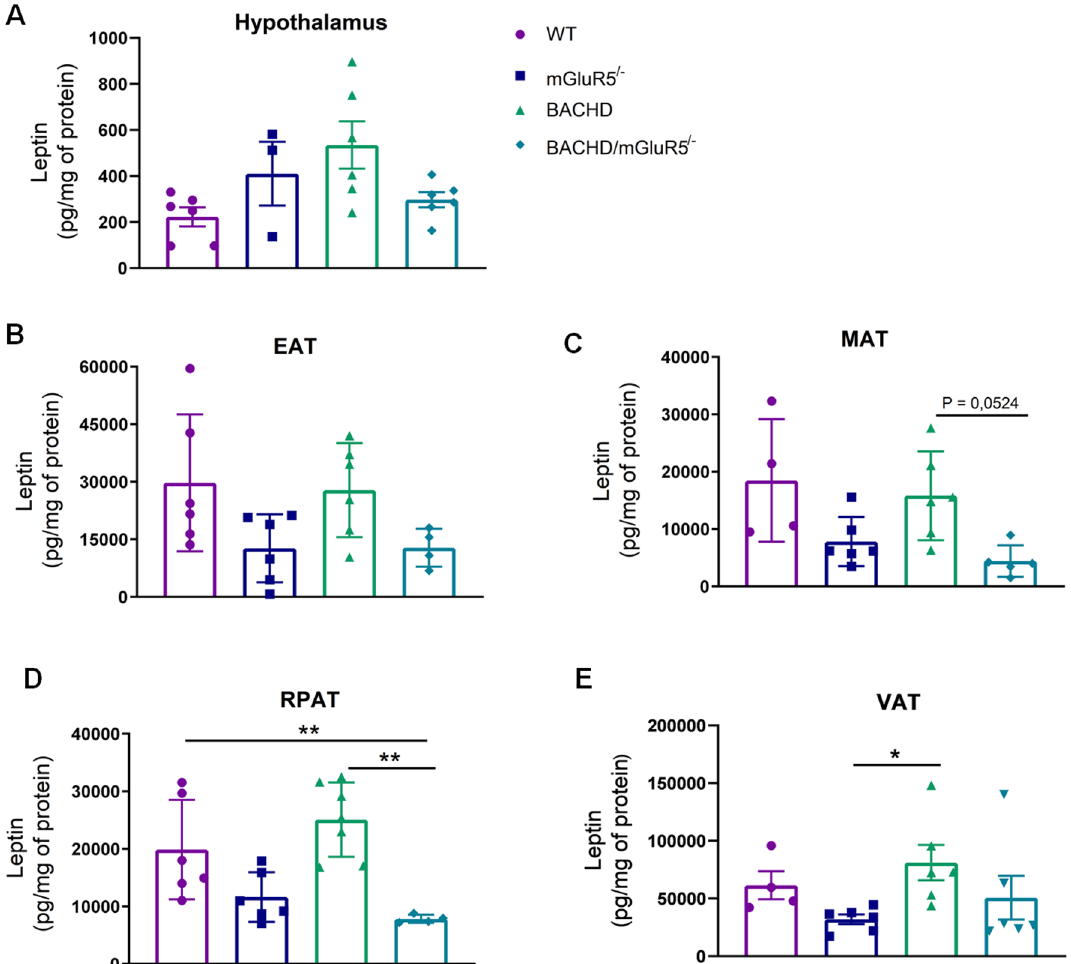
Figure 5. The absence of mGluR5 decreases leptin levels in BACHD mice at 12 months of age ( A – E ) Leptin levels in the hypothalamus, epididymal (EAT), mesenteric (MAT), retroperitoneal (RPAT) adipose tissue, and in the sum of visceral adipose tissues (VAT) of WT, mGluR5 −/− , BACHD and BACHD/mGluR5 −/− mice at 12 months of age. Error bars represent the mean ± SEM; n = 4–7. One-Way Welch ANOVA followed by Games- Howell’s post test ( A – D ), and Kruskal–Wallis followed by Dunn’s post test ( E ). * p < 0.05; ** p <